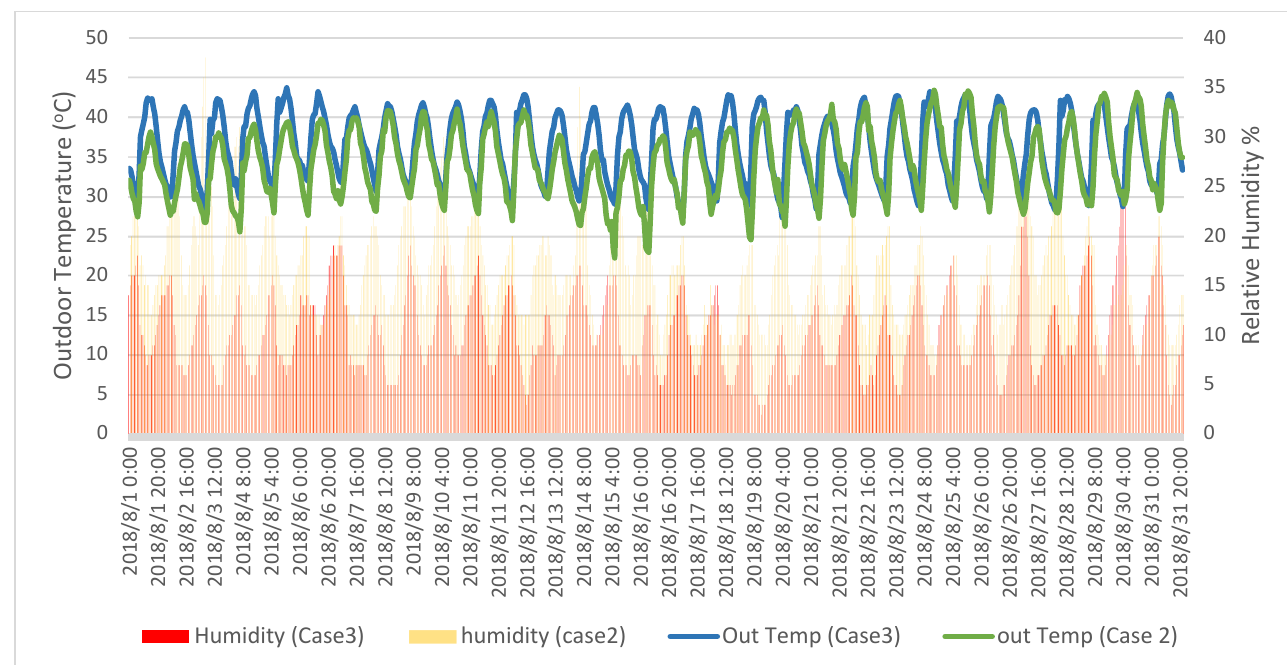
Figure 12. Cases 2 and 3 hourly measured outdoor weather data for August 2020. A comparison of Case 2 and Case 3, Figure 12 indicated that the long trees in Case 2 led to a significant deviation in relative humidity of 53.2%, which significantly reduced the outdoor temperature by 5.5%. Trees also reduced long-wave radiation from the ground, sky, and surrounding buildings. The warming effect of leaves on the urban air is also very significant [27]. Figure 13a,b depicts the top view of Cases 2 and 3, respectively, demonstrating how the green area modifies the sites’ planes in the specified cases.